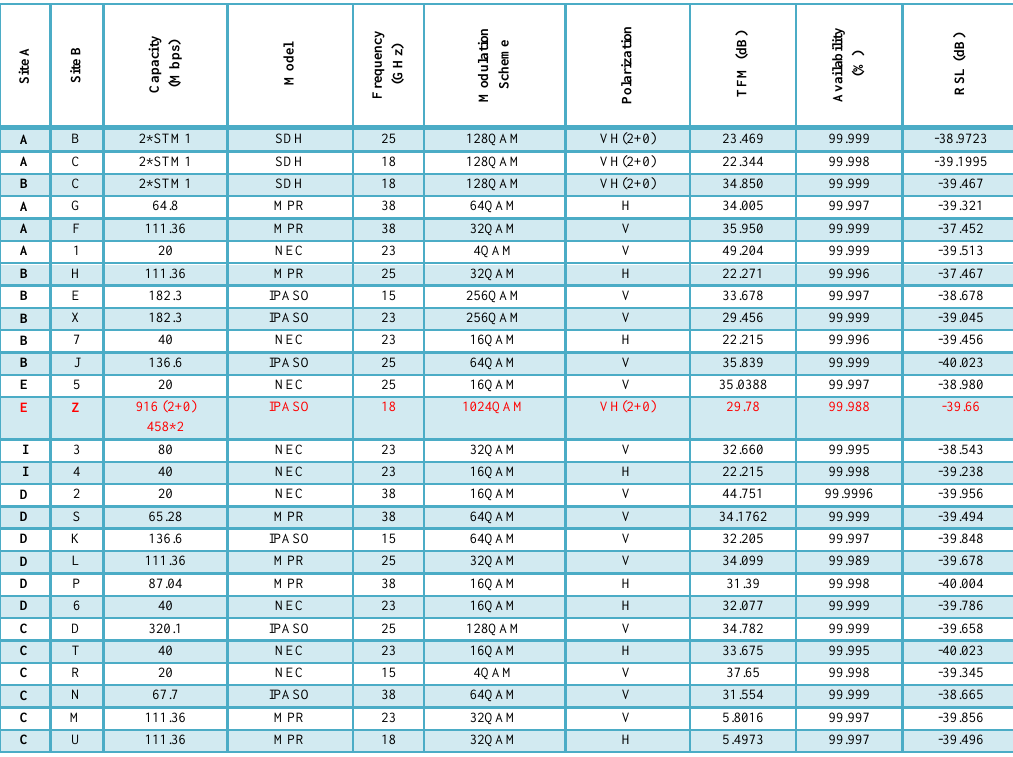
Table 3. Radio parameters of the links projected, part